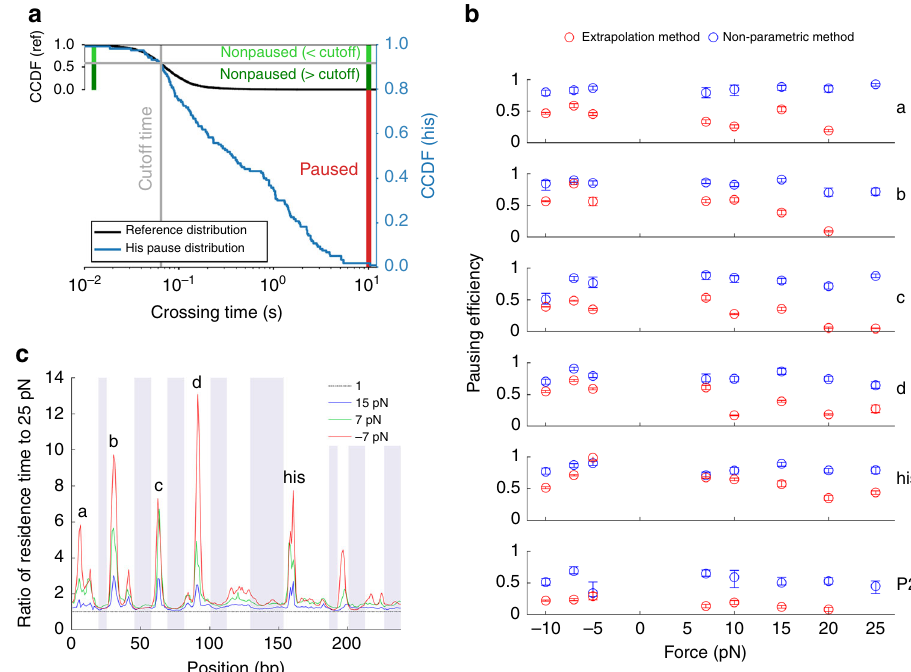
Fig. 2 Pausing ef fi ciencies are high and force-independent. a Description of the method used to calculate pausing ef fi ciencies, illustrated for the ‘ his ’ pause at 10 pN assisting force. The reference distribution is rescaled to indicate the overlap between the two distributions below the cutoff time. For the distribution at the ‘ his ’ site, all events shorter than the cutoff are classi fi ed as non-paused (light green), as well as events longer than the cutoff in the same proportion as in the reference distribution (dark green). The remaining events (red) are classi fi ed as paused. b Pausing ef fi ciencies at the major pause sites at different forces, calculated using extrapolation of the crossing time distributions above 1 s towards faster times (red), and by our nonparametric method (blue). Error bars indicate 25 – 75 percentiles for for 100 bootstrapped sets. c Residence time histogram ratios. The ratios of the residence times at three forces to the residence times at 25 pN assisting force are plotted. The ratio for 25 pN assisting force, which equals 1 by de fi nition, is plotted as a